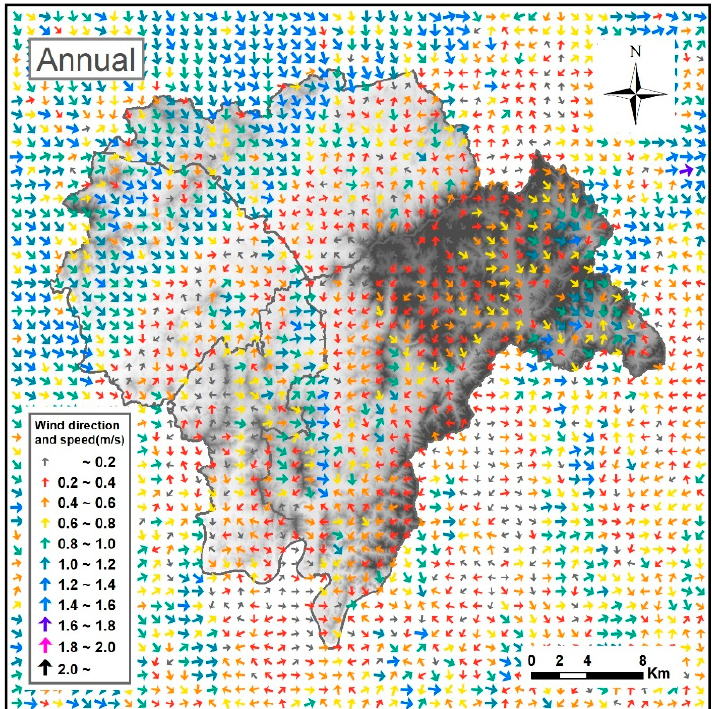
Figure 3. Annual wind field map of Cheongju-Si, Korea, in 2016. In the northern and western areas of Cheongju-si, northwesterly and westerly winds were prevailing, respectively; whereas in the eastern and southern areas, which are dis- tributed with relatively high hillslopes covered by forest, the wind speeds and directions showed significant variability dependent upon the locations, considered here to be the effect of the mountain-valley breeze. As for the winds entering the city center, the north- westerly and westerly winds prevailed during the day, while easterly winds from the mountains were predominant during the nighttime (Figure 4).